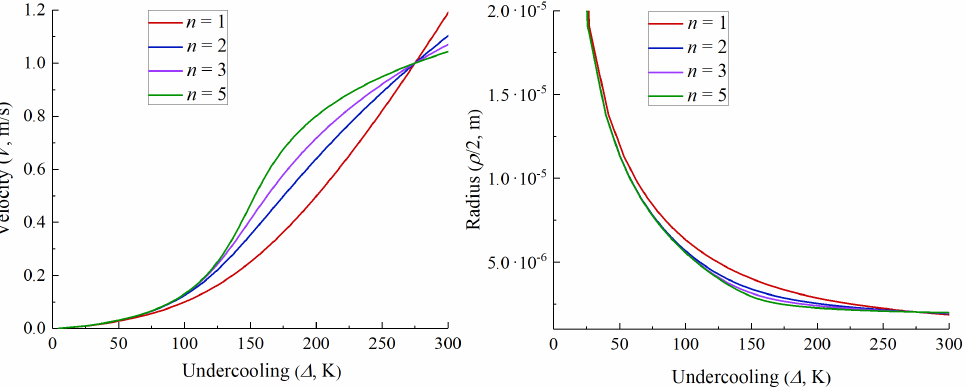
Figure 3. Dendrite tip velocity V and radius ρ /2 as functions of the melt undercooling ∆ for the pure Ni alloy. The colored lines represent the effect of different powers of the atomic kinetics exponent n . The parameters used in the calculation: solidification temperature T d 0 = 1728 K, hypercooling T Q = 435 K, temperature diffusivity D T = 1 × 10 − 5 m 2 s − 1 , kinematic viscosity of the liquid ν = 7.14 × 10 − 7 m 2 s − 1 , fluid velocity U ∞ = 0.001 m s − 1 , capillary length d c ≈ d 0 = 4.2 × 10 − 10 m, kinetic coefficient β k = 0.01 m (s K) − 1 , surface energy anisotropy ε c = 0.02, selection constant σ 0 = 0.05, selection parameter responsible for fluid flow b =